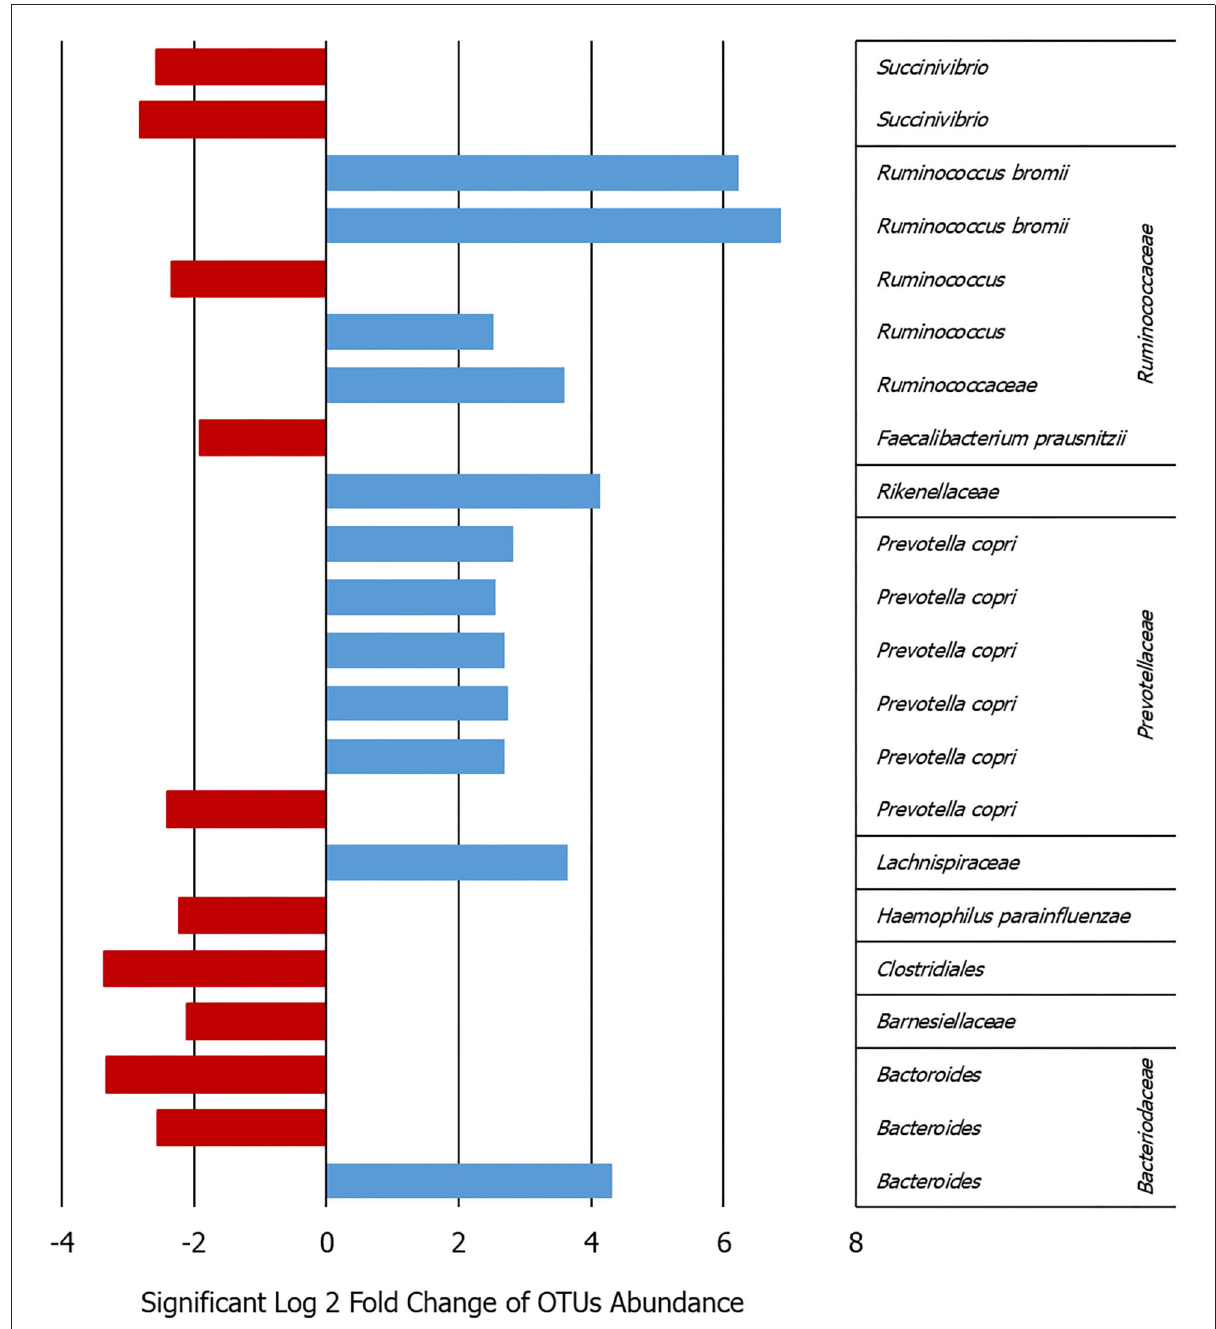
FIGURE1 Bar graph showing the log2-fold change calculated by DeSeq2 in the patients between the onset and follow-up for the 22 OTUs that varied significantly in their abundance adj. p < 0.0009 (details given in Supplementary Figure 2).